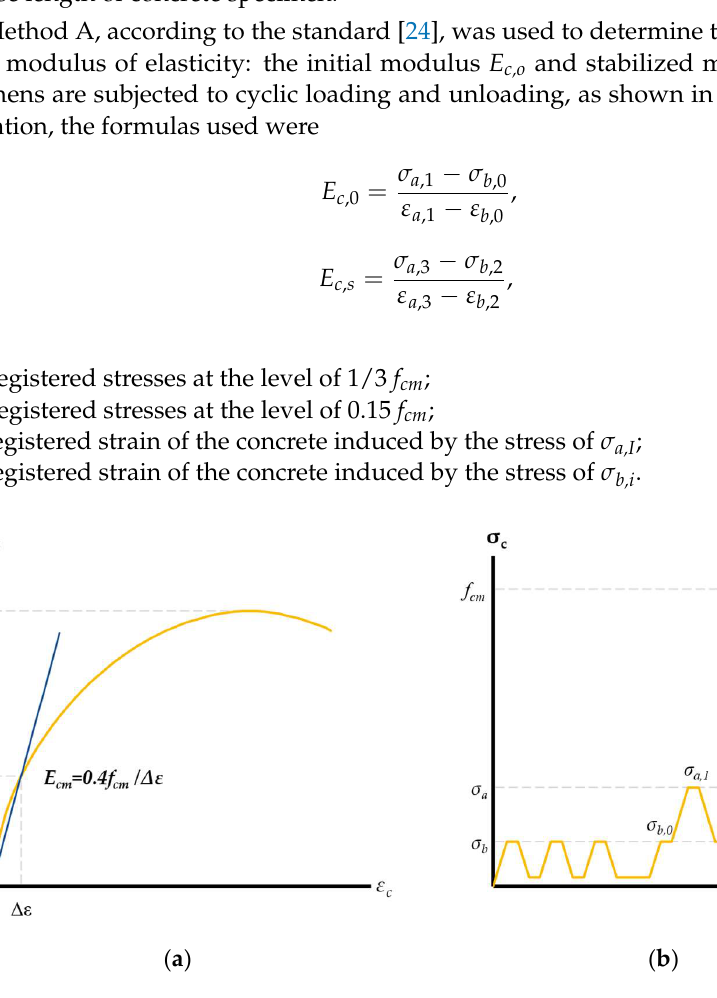
Figure 7. Specimen loading process: direct method ( a ) and method A ( b ).